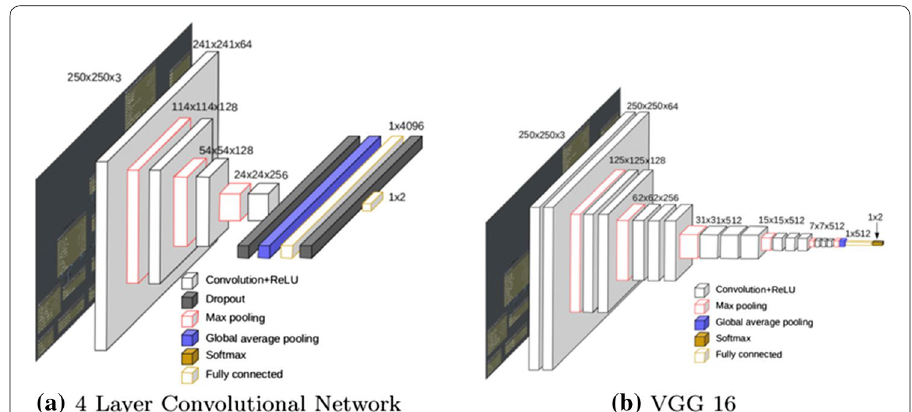
Fig. 1 Visuals of the networks used. a The four convolutional layers, interspersed with max pooling for downsampling followed by dropout, max pooling, and fully connected layers for classification. b Standard VGG network with sixteen convolutional